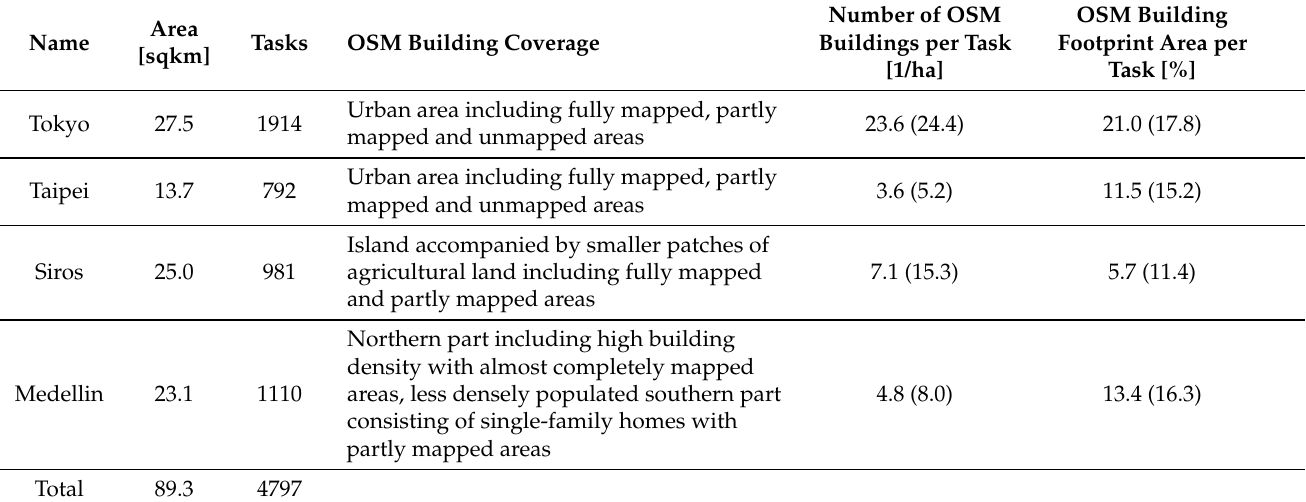
Figure 2. Case study locations. The completeness of mapping in OSM differed across and within the case studies. However, all four case studies contained a large number of OSM features as indicated by the detail maps which were limited for this figure to the most relevant features (main roads and building footprints). Data source: OpenStreetMap contributors under ODbL and Natural Earth (world map). Map tiles for detailed maps by Carto, under CC BY 3.0. Table 1. Characterization of the MapSwipe projects used as case study sites for the assessment of building completeness. For the average number of buildings and the average building footprint area per task area, the standard deviation is provided in